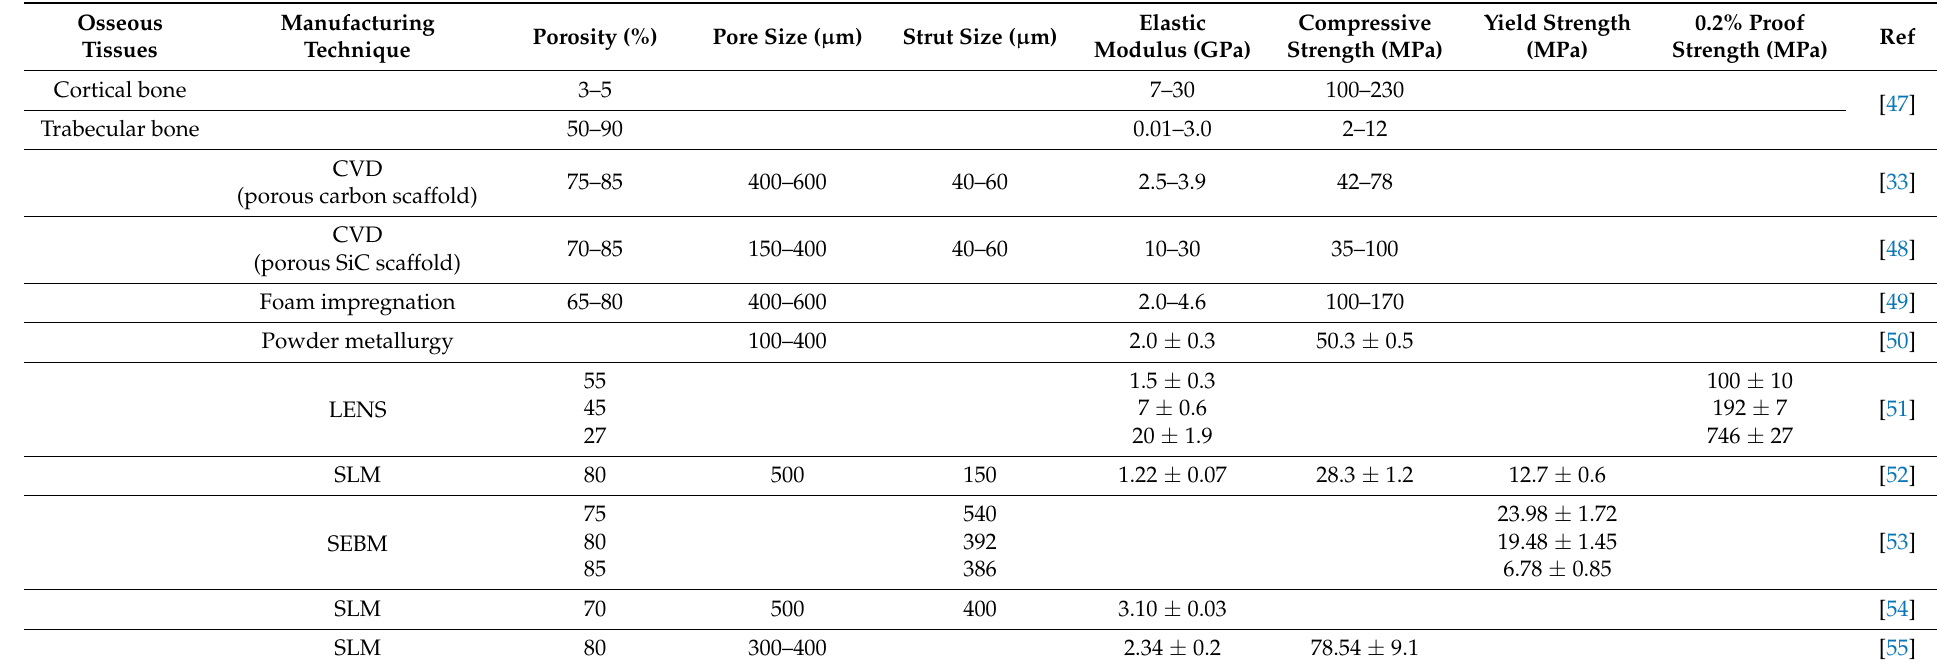
Table 1. The mechanical properties of osseous tissues and porous Ta produced by different